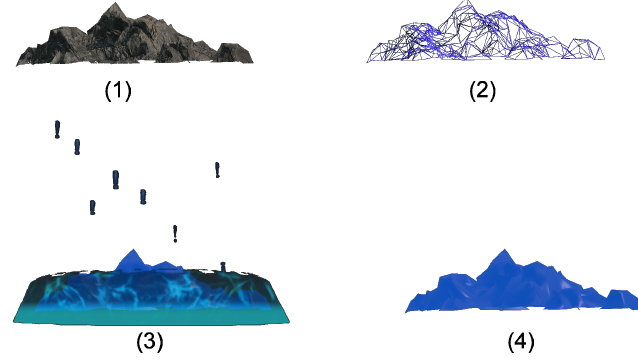
Figure 10. The material evolution of a rock obstacle being